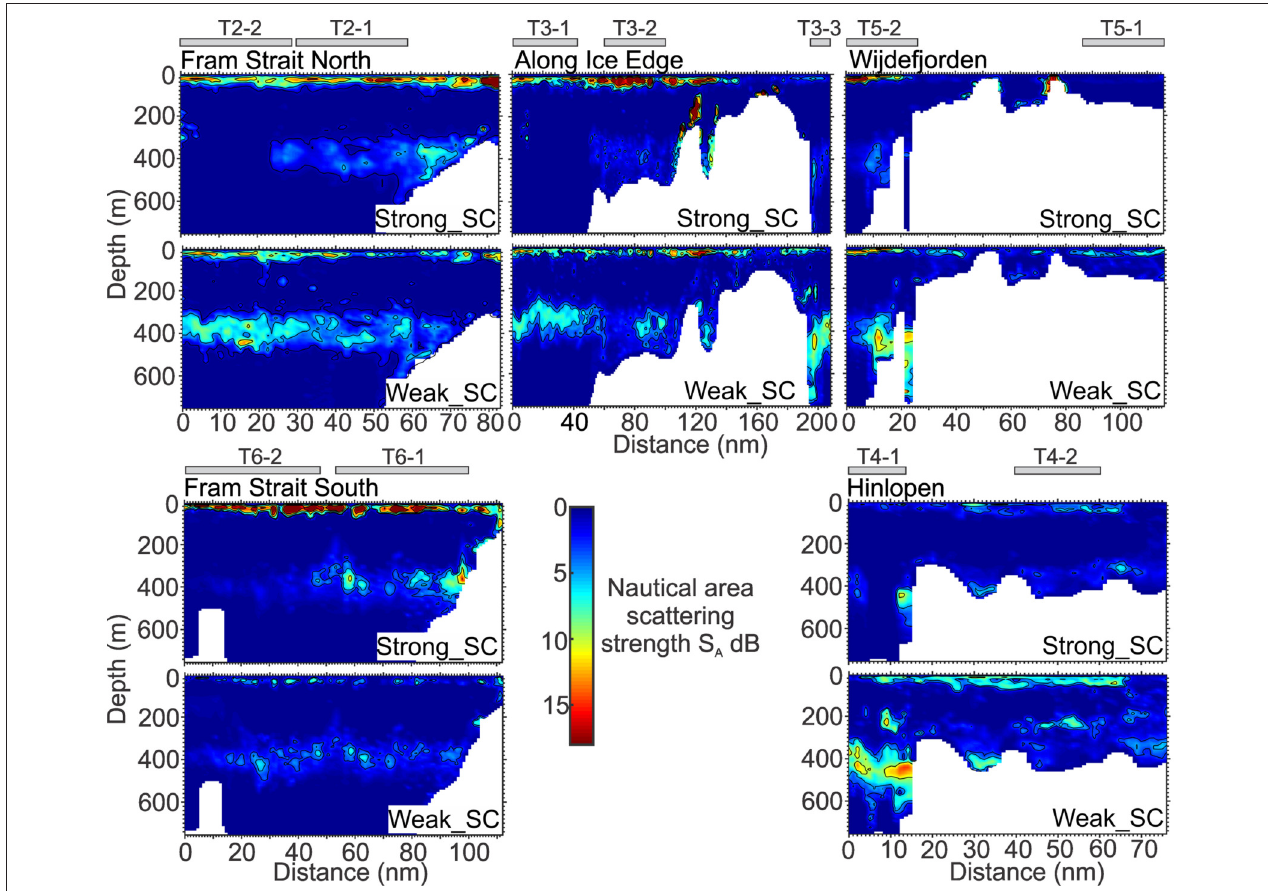
FIGURE 4 | Distribution of the strong backscatter category (Strong_SC, Upper ) and the weak backscatter category (Weak_SC, Lower ) for the transects, Fram Strait South (T6), Fram Strait North (T2), Along Ice Edge (T3), Wijdefjorden (T5), and Hinlopen (T4). Values are the Nautical area scattering strength, S A = 10*Log10 (s A ), dB re 1(m 2 nmi − 2 ). Gray rectangles above transects indicate position of subsections. x-axes are of unequal